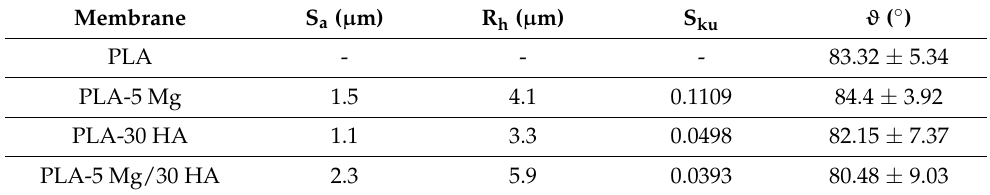
Table 2. Membrane surface properties : surface average roughness (S a ), average height to the peaks (R h ), Kurtosis parameter (S ku ), average contact angle ( ϑ